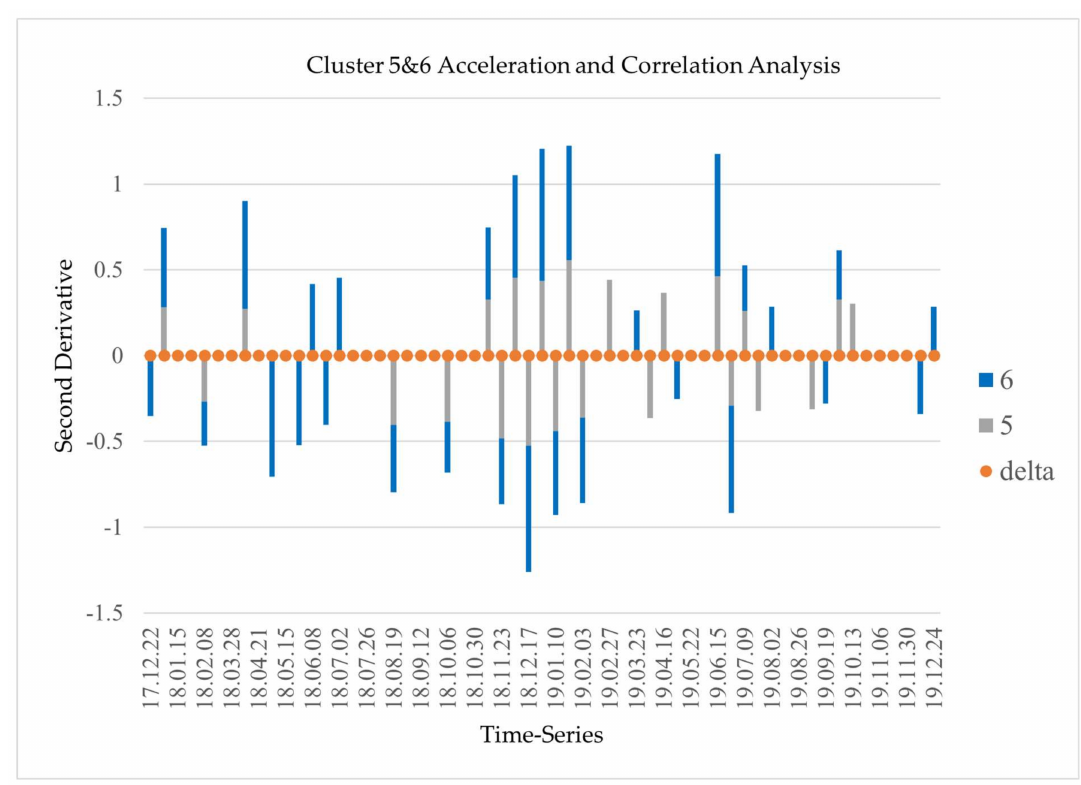
Figure 11. Inflection dates using stable (cluster 5) and stable (cluster